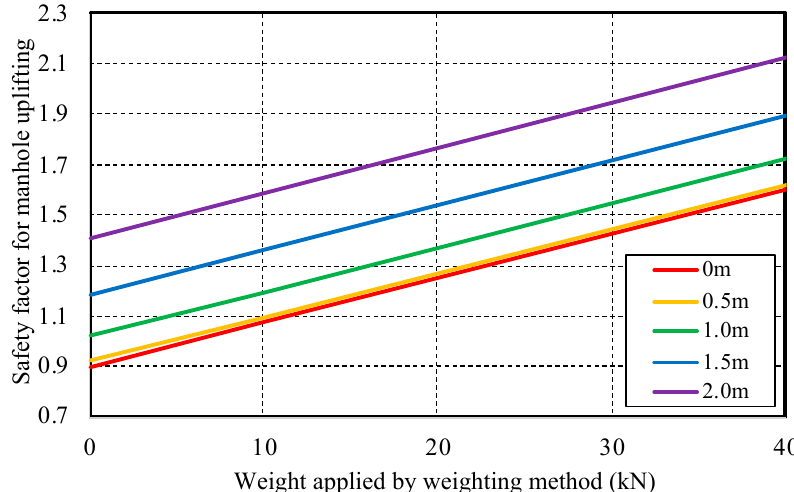
Figure 9. F S for No. 1 circular manhole when groundwater level is changed.